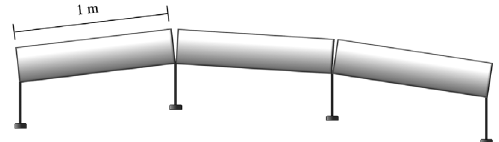
FIG. 3. Model 2: Tilted guide pieces of 1 m length, where the ends of adjacent guide pieces are mounted on the same pillar.